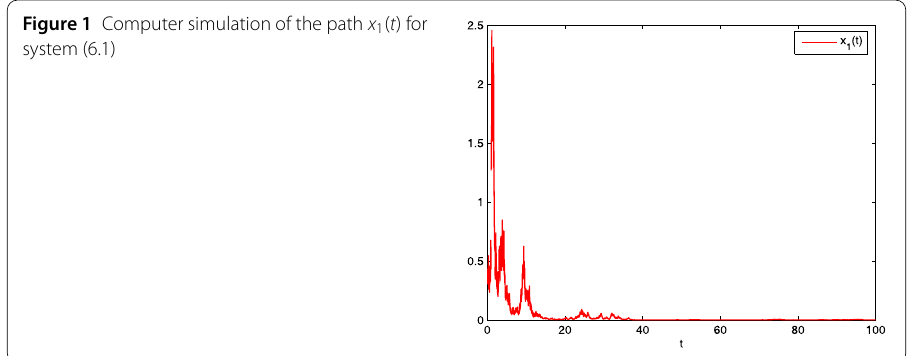
Figure 1 Computer simulation of the path x 1 ( t ) for system